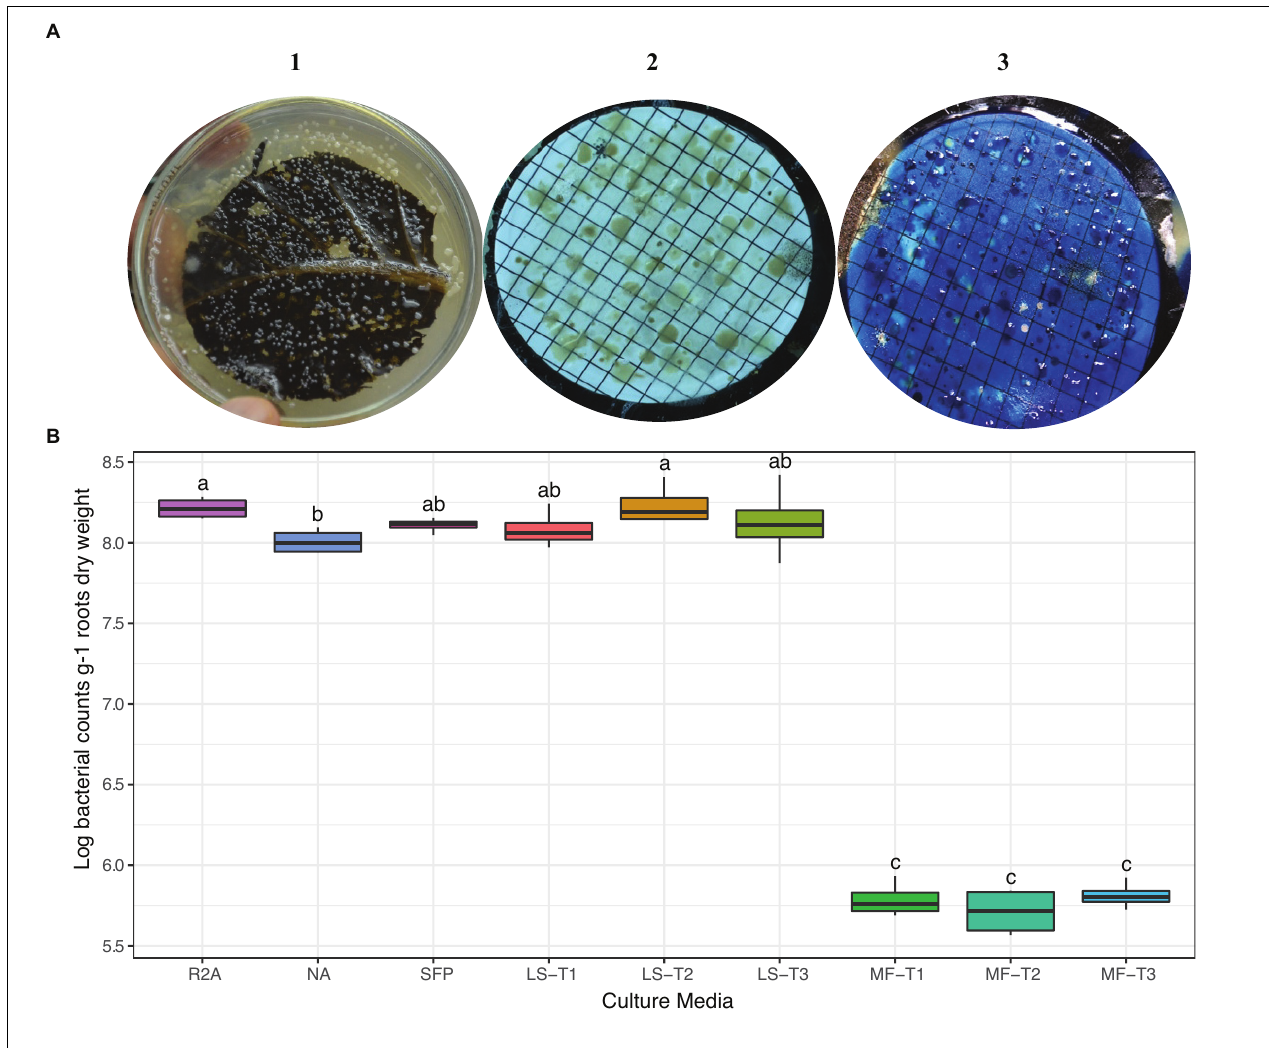
FIGURE 1 | (A) Colony morphology of bacteria isolated from the rhizosphere of sunflower plants cultured on different culture media. CFUs developed on the leaf surface-inoculated culture medium (1) and by the leaf-membrane filter method (2); notice the better resolution of colonies when membrane filters were stained with methylene blue (3). (B) ANOVA test of log CFU counts of rhizobacteria recovered by standard culture media (R2A medium; nutrient agar, NA; sunflower teabag, SFP) and leaf-based culture media (LS, leaf-surface-inoculated; MF, leaf-membrane filter). Physical leaf pre-treatments: punching, T1; punching and pressing, T2; punching, pressing, and scratching, T3. Statistically significant differences (LSD) are indicated by different letters ( P value